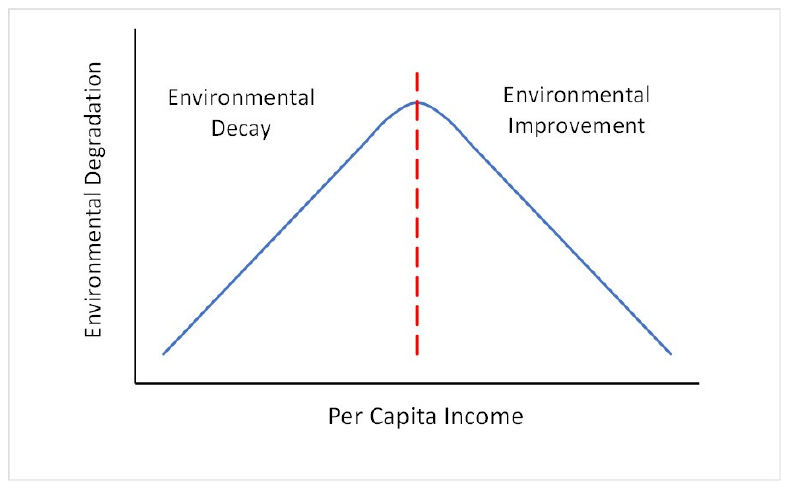
Figure 1. The environmental Kuznets curve.